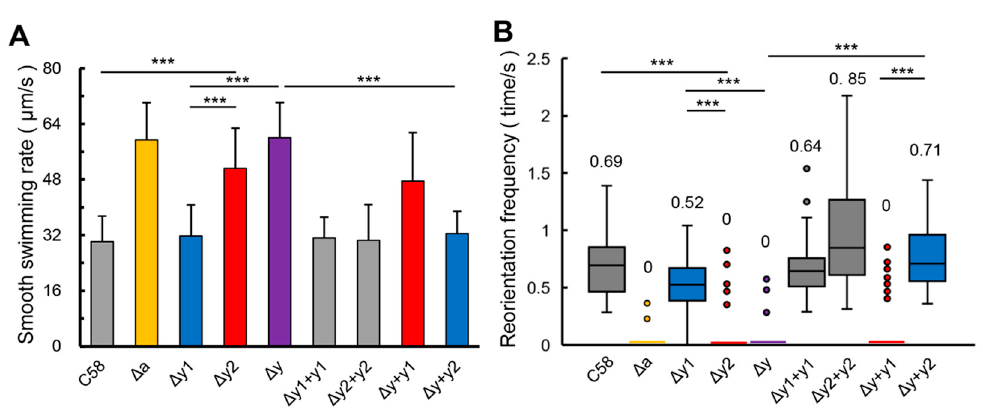
Figure 2. Effects of two CheYs on the free-swimming behavior of A. fabrum cells. The cells of different A. fabrum strains, which can express eGFP as the reporter protein for tracking their swimming tracks, were harvested at middle-logarithmic phase, washed, and resuspended in buffer at room temperature. Fifty cells of each strain were recorded by digital camera to analyze their swimming behaviors. ( A ) Average swimming speed (µm/s) of various A. fabrum strains. The bars con- nected by “***” mark means that are different in a statistically significant manner at p < 0.001 via the unpaired Student’s t test. ( B ) Tukey box plot of reorientation frequency (s -1 ) of various A. fabrum strains. Box displays the 25–75th percentile of the observations. The bars indicate the maximum and minimum value. The horizontal line within the box indicates the median, the value of which is also displayed above the respective box. The line in the horizontal axis represents that most of the observations are zero and dots represent outliers. The boxes connected by the “***” mark mean that they are different in a statistically significant manner at p < 0.0001 via the Wilcoxon–Mann–Whitney test. The strain names represented by the labels in the horizontal axis are the same as in Figure 1. 3.3. Both CheY1 and CheY2 Interact with CheA at the Cell Pole Respectively As we know, MCPs are located at the cell poles and CheW couples CheA to MCPs to form the stable MCP-CheW-CheA ternary complex [10]. CheY, as the response regulator of chemotaxis, can bind to CheA and be phosphorylated by the phosphoryl group from the phosphorylated CheA [8]. If both CheY1 and CheY2 of A. fabrum were involved in the chemotaxis signaling transduction, the co-localization of CheA and CheY1 (or CheY2) at cell poles could be observed. To visualize the co-localization of CheA and CheY1 (or CheY2) in the A. fabrum cell, eGFP was split into two non-fluorescent parts (N-terminal part and C-terminal part) at the peptide bond between residues 158 and 159 [39]. The C- terminal part (C egfp ) of eGFP was fused to the C-terminus of CheA to form the CheA- C egfp fusion protein and the N-terminal part (N egfp ) of eGFP was fused to the C-terminus of CheY1 (or CheY2) to form the CheY1-N egfp (or CheY2-N egfp ) fusion protein. The inter- action between CheA and CheY1 (or CheY2) brings two split-eGFP parts together and makes the reconstituted eGFP emit fluorescence. To eliminate the possible effects of the in-situ CheA, CheY1 and CheY2 on the interactions between these fusion proteins, the fusion protein-expressing plasmid was introduced into the cheA - cheY1 - cheY2 triple-dele- tion mutant ( Δ ay). The cheY1 - cheY2 double-deletion mutant ( Δ y) carries a plasmid, which can express the CheY1-Negfp fusion protein and C egfp (C-terminal part of eGFP), was used as the negative control. As shown in Figure 3, clear polar fluorescence focus was observed in A. fabrum cells expressing two pairs of fusion proteins (CheA-C egfp paired with CheY1-N egfp and CheA-C egfp paired with CheY2-N egfp ), respectively. Compared with CheA-C egfp /CheY2-N egfp , CheA-C egfp /CheY1-N egfp produced a higher percentage of polar fluorescence and the presence of one native CheY could significantly prohibit the other CheY fusion protein from interacting with CheA-C egfp . These results demonstrate that CheY1 and CheY2 interact with CheA competitively and the affinity of CheY1 to CheA is higher than that of CheY2. The absence of CheS slightly affected the interactions of both CheY1 and CheY2 with CheA. Figure 3 also showed that there was no interaction between two CheY proteins.